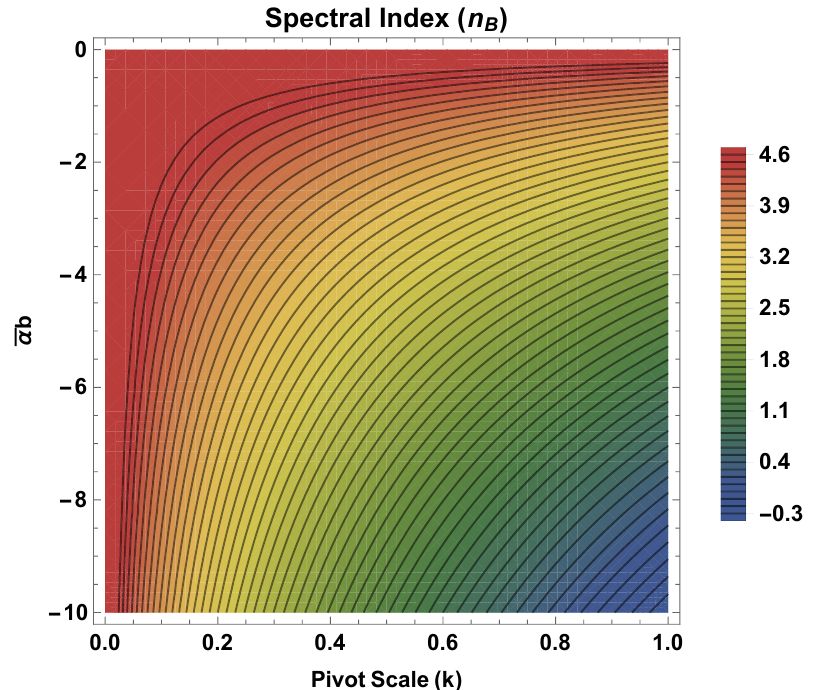
Figure 4. The above figure demonstrates the magnetic spectral index n B with both the pivot scale k (in Mpc − 1 ) and the parameter ¯ α b . Each contour depicts one constant value of the magnetic spectral index. As evident from the colour coding the spectral index varies from values greater than unity to values less than unity, while passing through one, which would depict scale invariance power